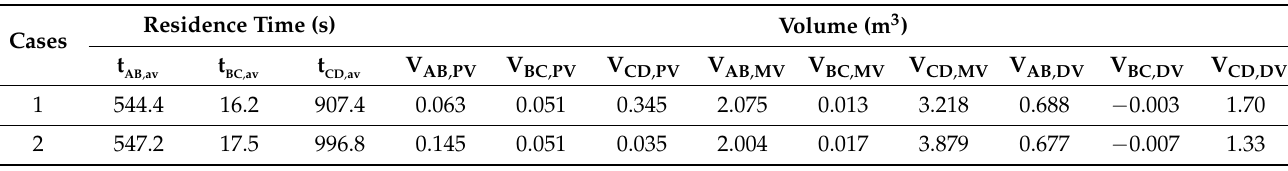
Table 7. Analysis results for the RTD curve with the combined model in the tundish with and without channel induction heating.